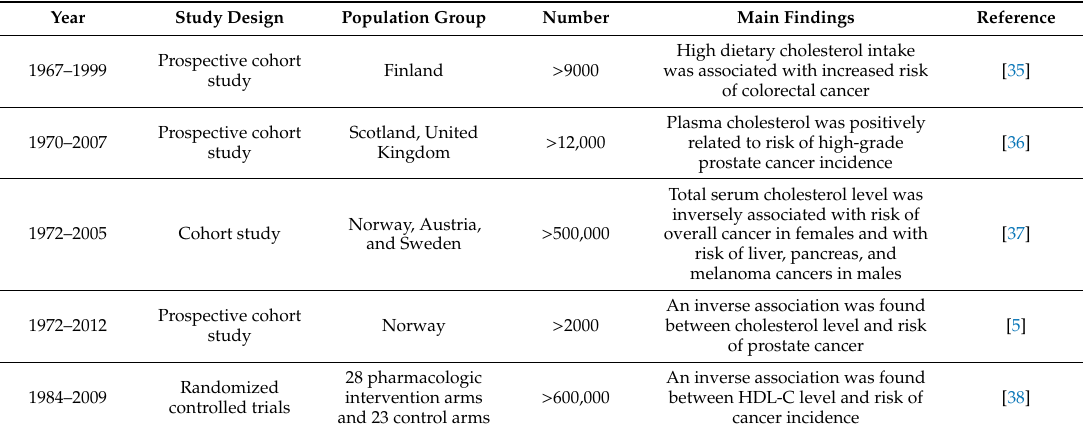
Table 1. Clinical and epidemiological studies linking cholesterol, statin use, and cancer